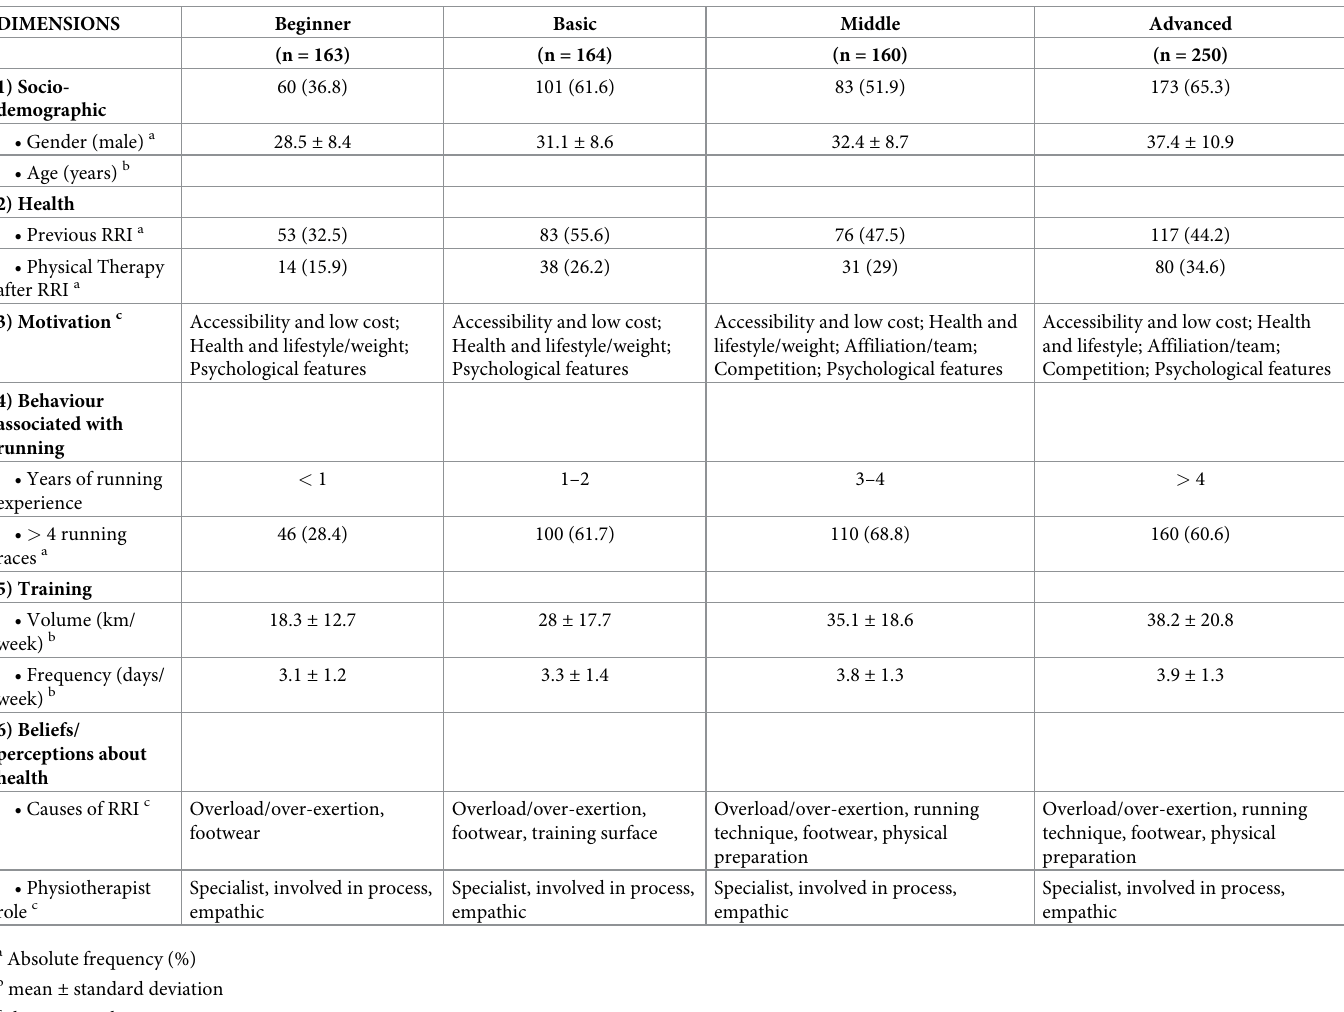
Table 3. Summary of quantitative and qualitative results according to SeRUN 1 profiles